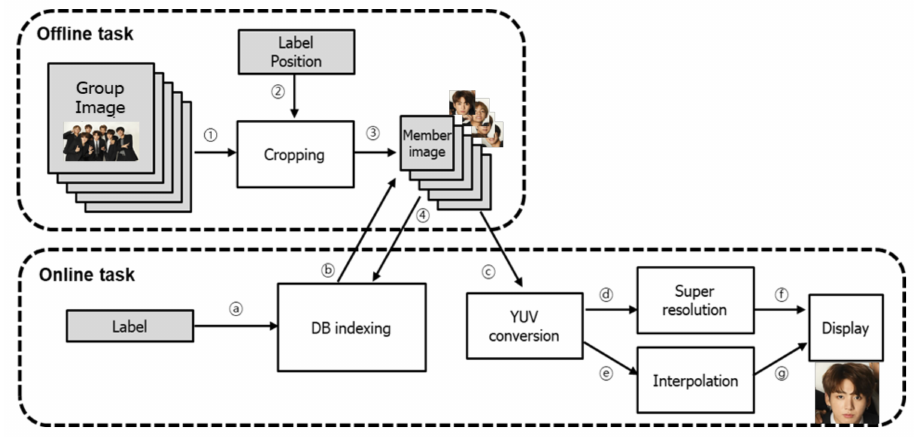
Figure 4. Focus fancam application